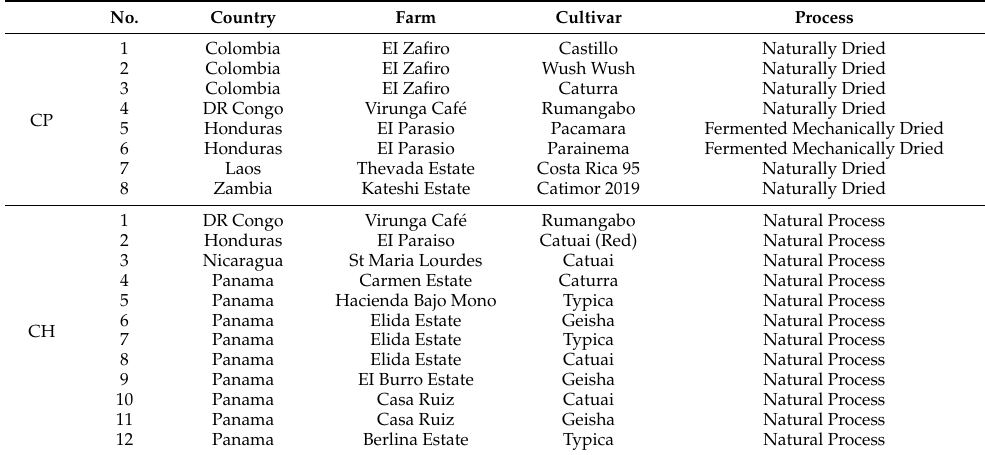
Table 1. Detailed information of coffee cascara